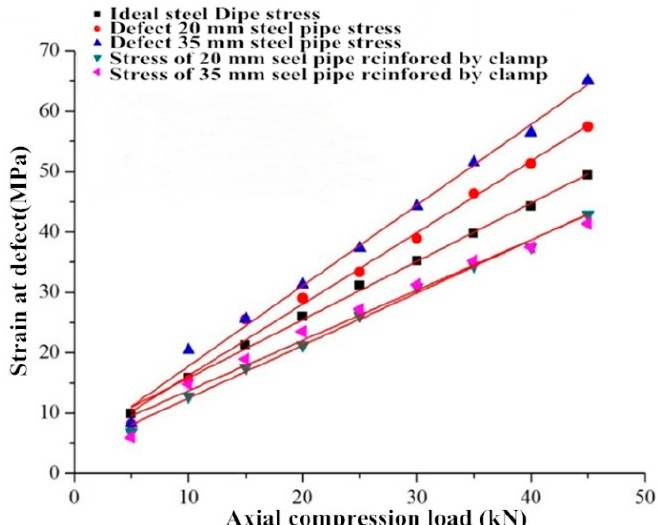
Figure 18. Stress at axial load measurement point.